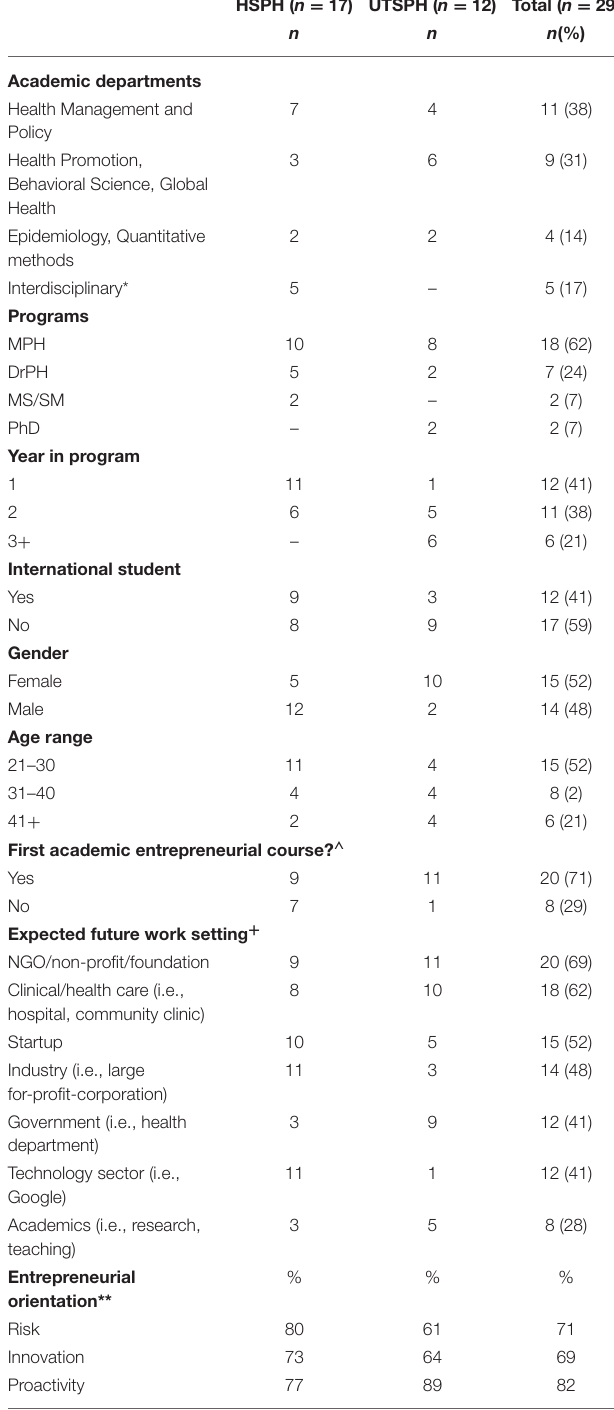
TABLE 2 | Participant demographic survey